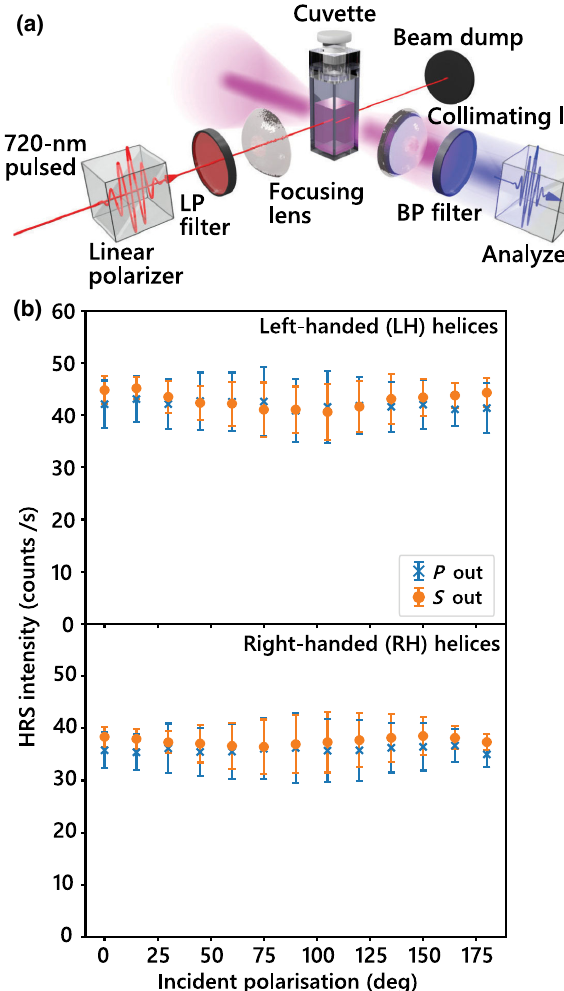
FIG. 3. The nanohelices are isotropically suspended in water. (a) Schematic of the setup used to measure hyper-Rayleigh scattering of linearly polarized incident light. (b) P -polarized (blue crosses) and S -polarized (orange dots) HRS intensity at 360 nm, as the polarization of 720-nm incident light is rotated. Both left-handed (LH) and right-handed (RH) nanohelix suspen- sions exhibit no variation outside of experimental uncertainty, demonstrating a clear isotropic arrangement of helices within the liquid